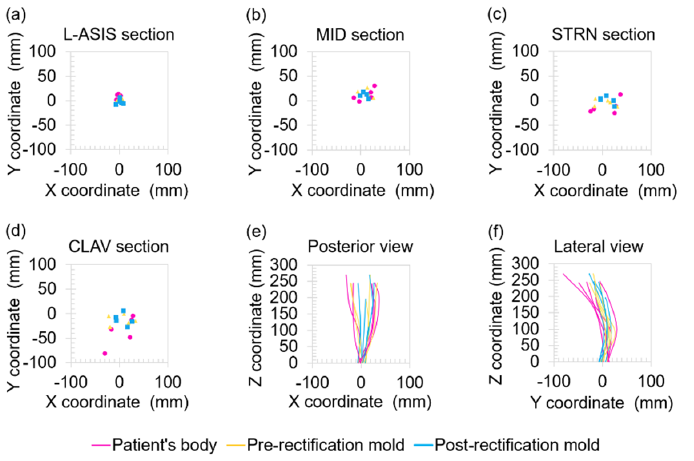
Figure 6. Centroid locations of the body scan, pre-, and post-rectification mould scans for the different patients. ( a – d ) are the coordinates of the centroids at each transverse section for all the patients. ( e , f ) are the centroid trajectories from the posterior and lateral view, respectively.